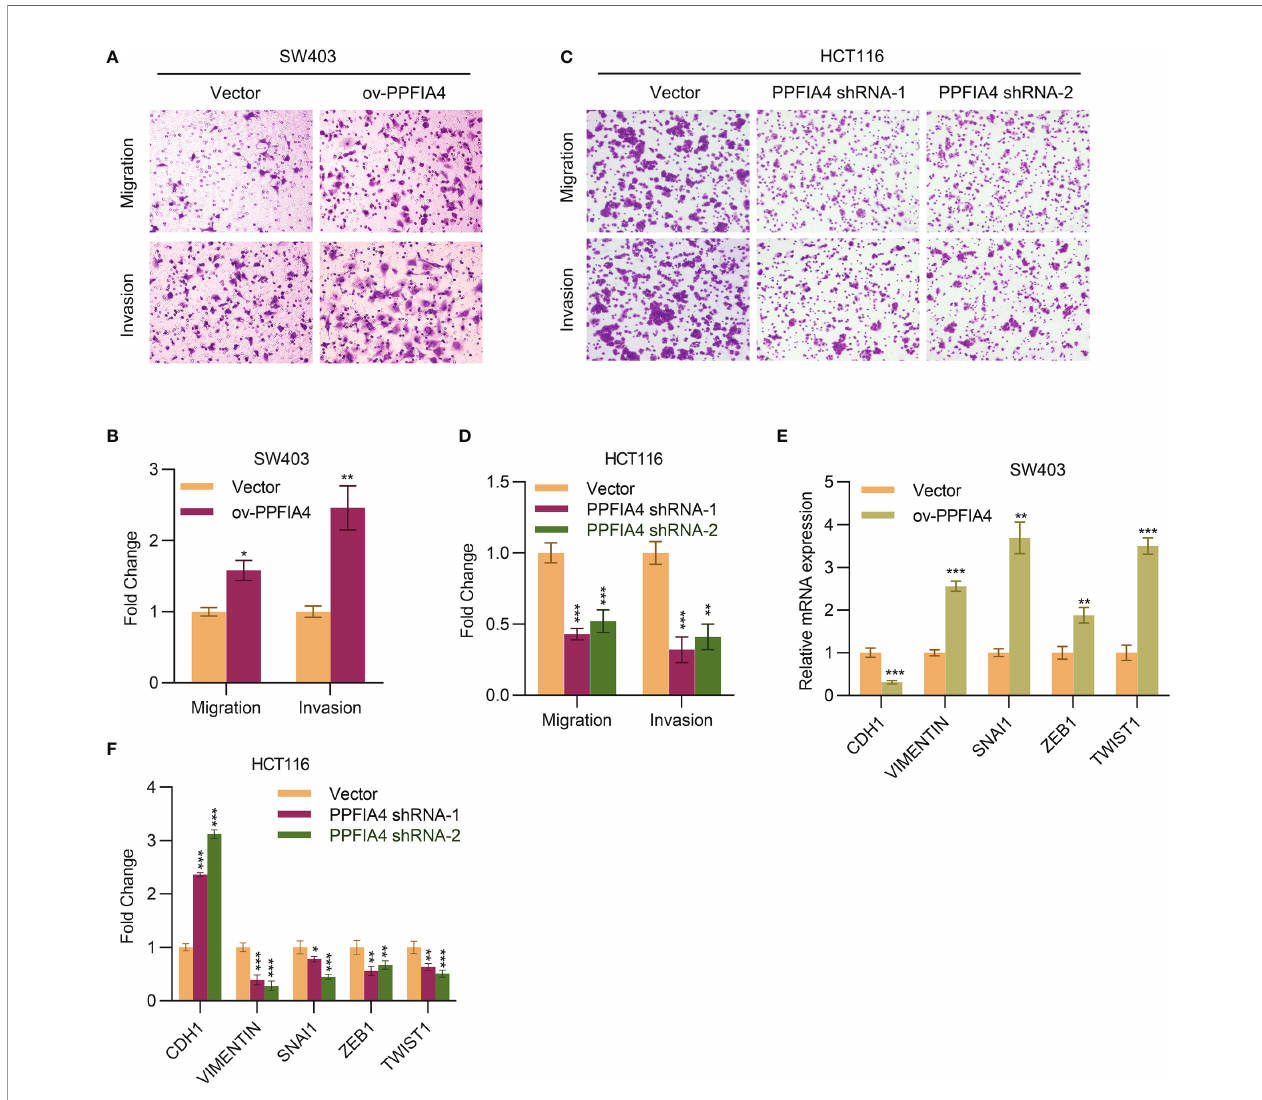
FIGURE 3 | PPFIA4 induces colon cancer migration and invasion. (A, B) Transwell assay to determine cell migration and invasion of SW403 cells transfected with PPFIA4 expression plasmid (A, B) and HCT116 cells transfected with PPFIA4 shRNA (C, D) . (E) mRNA levels of EMT markers in SW403 cells transfected with PPFIA4 expression plasmid. (F) mRNA levels of EMT markers in HCT116 cells transfected with PPFIA4 shRNA. *p < 0.05, **p < 0.01, ***p <